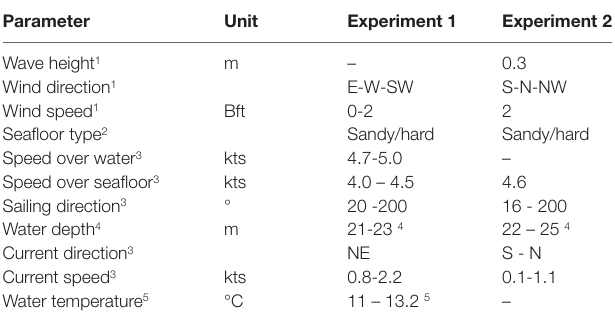
TABLE 1 | Experimental conditions. Parameters were recorded per sampled tow. Presented are the minimum and maximum values recorded